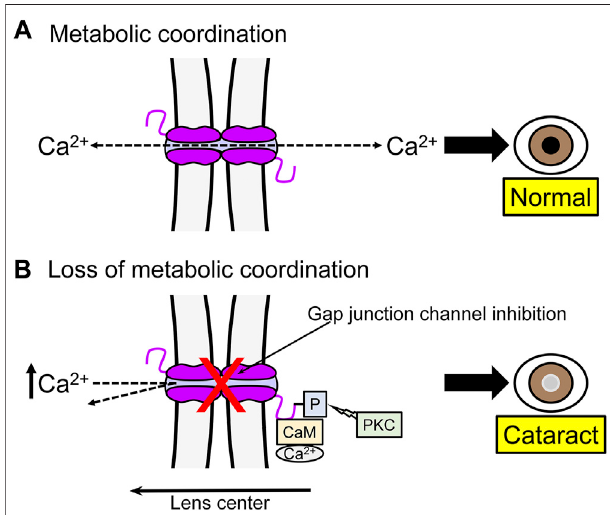
FIGURE 3 | One example of the role of gap junction channels in metabolic coordination between lens fi ber cells. (A) Normal junctional coupling. Under normal conditions gap junction communication prevents Ca 2+ accumulation in lens fi bers. The Ca 2+ transported from the central to peripheral cells is extruded by the Ca 2+ pump and a Na + /Ca 2+ exchanger. (B) Loss of gap junctional coupling. Inhibition of gap junction communication canleadtoCa 2+ accumulationanddevelopmentofcataracts.Factorssuchas phosphorylation(-P)ofCx46andassociationwithCa 2+ -calmodulin(CaM)can inhibit gap junction